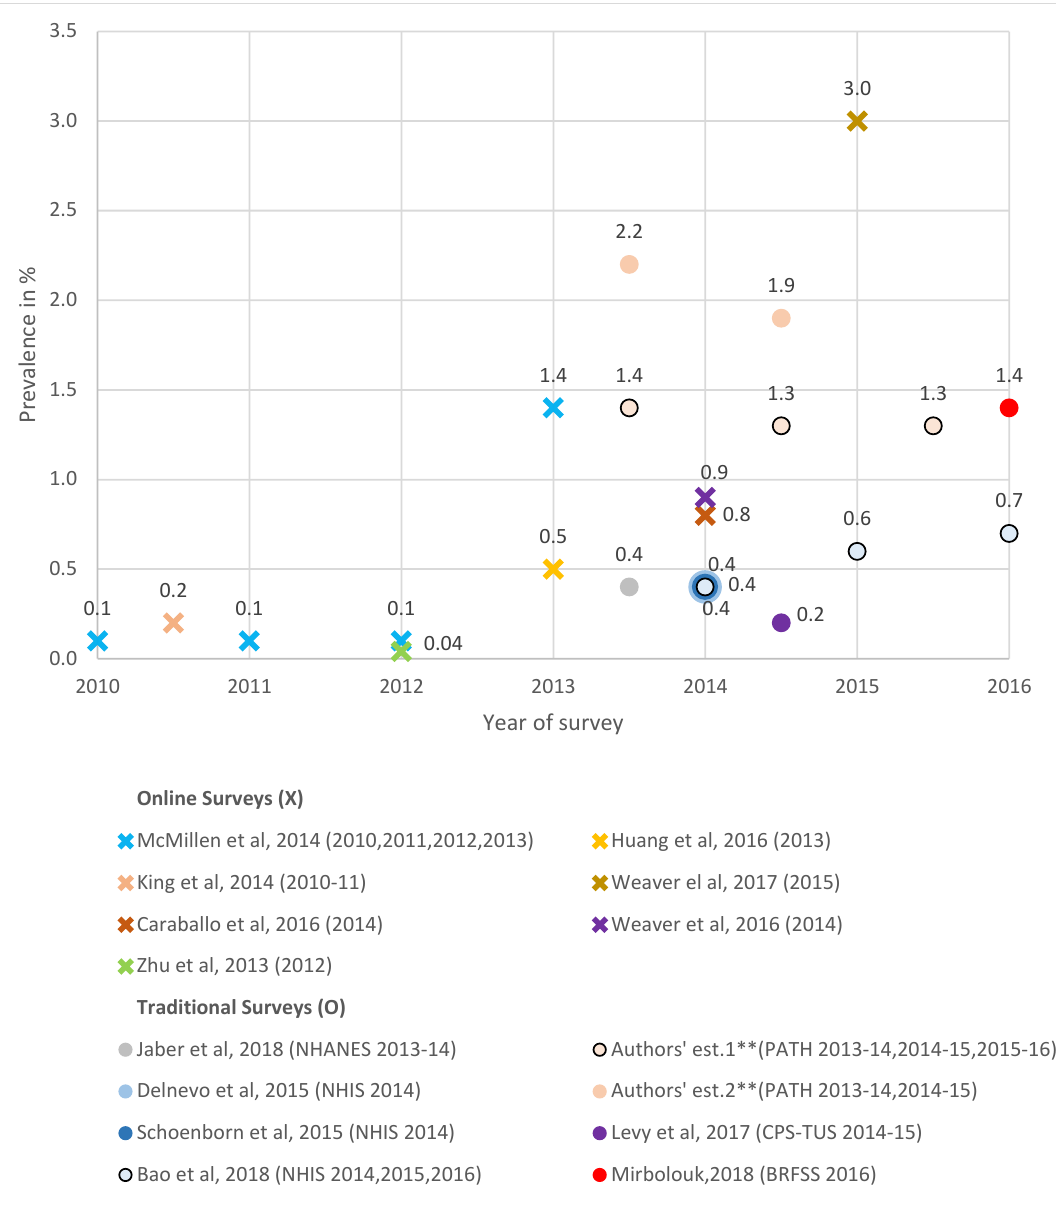
Figure 4. The prevalence of current e-cigarette/ENDS use among never smokers, online and traditional survey estimates *, 2010–2016. * The estimates from online surveys are indicated by an X, and the estimates from traditional surveys are indicated by a circle. The legend adopts the format “author’s name, publication year (survey name and year(s)),” and the names of all online surveys are omitted. For surveys that collected data over a two-year period, we plotted the estimates in the mid-period. ** Authors’ estimate one is measured by daily/nondaily ENDS use, and authors’ estimate two is measured by past-30-day ENDS use.